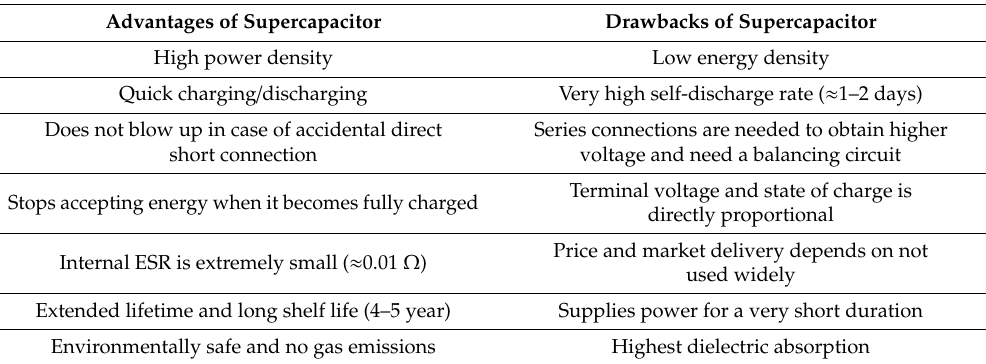
Table 1. The summarize of advantages and drawbacks of supercapacitors [5,7,16,17].